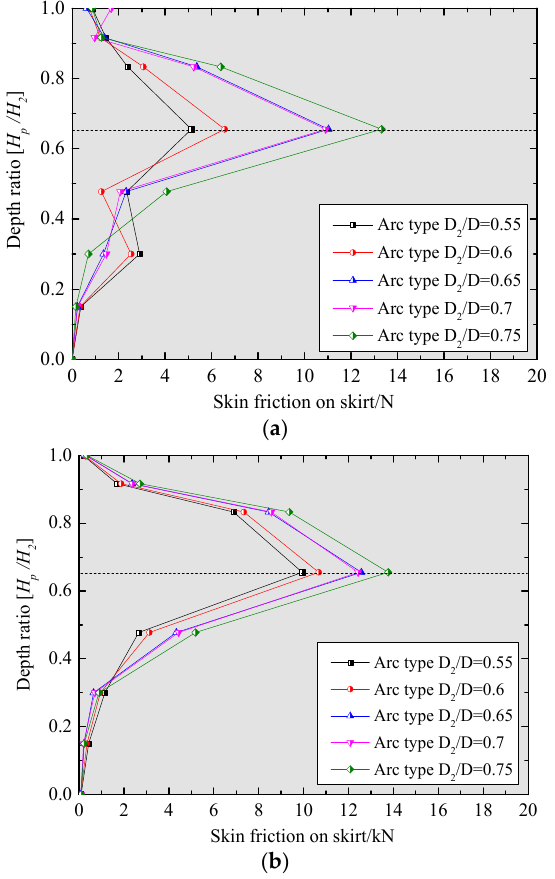
Figure 19. Skin friction on the back bucket: ( a ) Outside skirt; ( b ) Inside skirt.